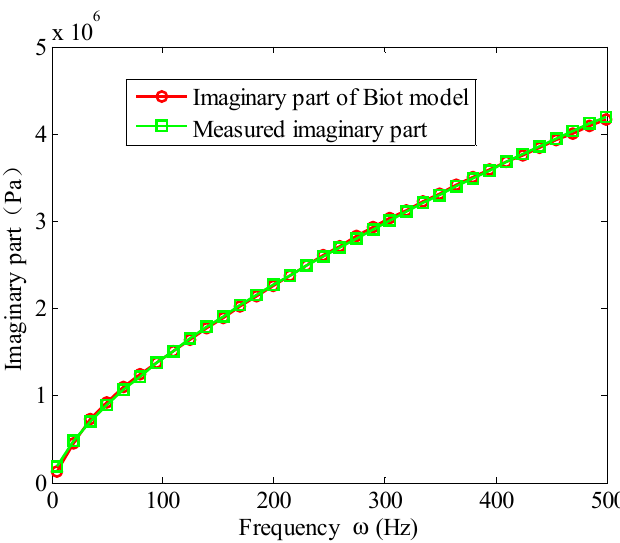
Figure 7. Real part fitting of the Biot model.